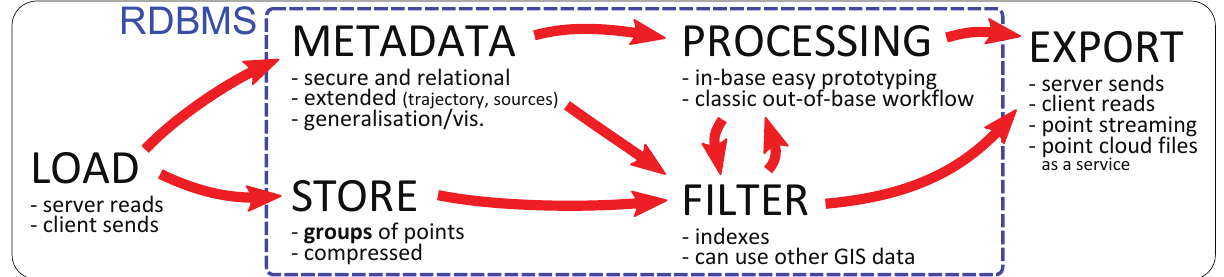
Figure 1: In-base point cloud management pipeline. table. Groups of points are called patches of point. An